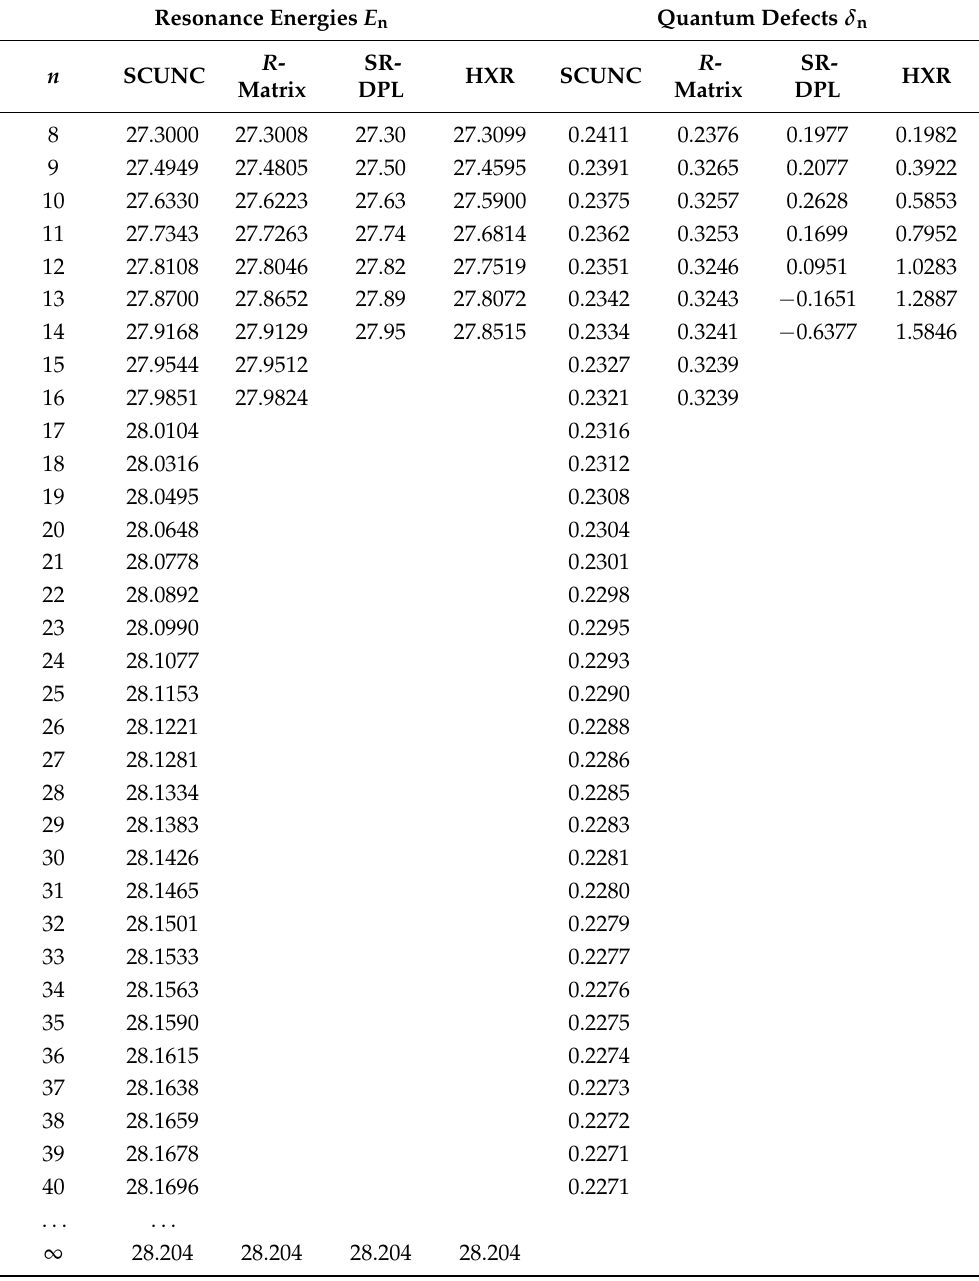
Table 6. Resonance energies (in eV) and quantum defects (dimensionless) of the 4s 2 4p 5 ( 2 P ◦ 1/2 ) n d results are compared to the synchrotron radiation (SR) and dual laser plasma (DPL) measurements of Kilbane et al. [9] along with their theoretical results from Hartree-Fock with exchange plus relativistic corrections (HXR) [9] and with the Dirac R -matrix calculations of McLaughlin and Babb [17].